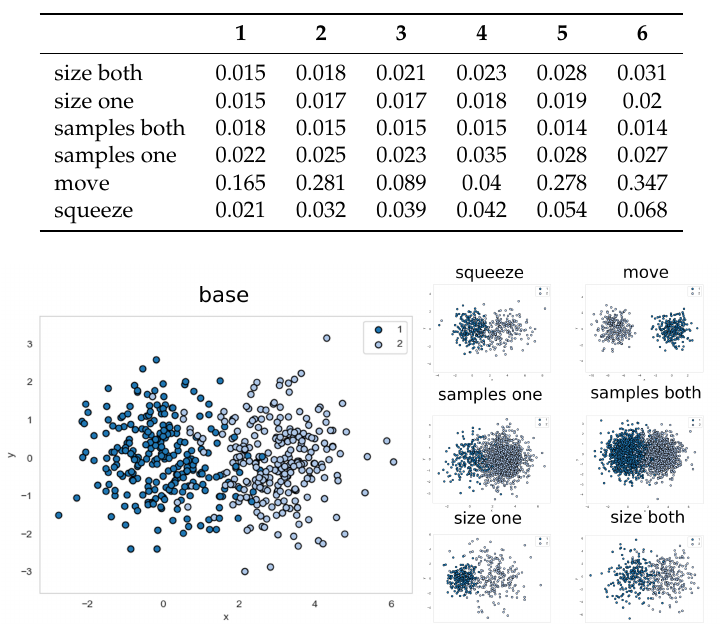
Table 3. Evaluation of the accuracy estimation error while applying CGEM to drifting data. Each drifting modifications to the base data set is evaluated in different linear intensities, where 6 the modification that most drifted away from training data.